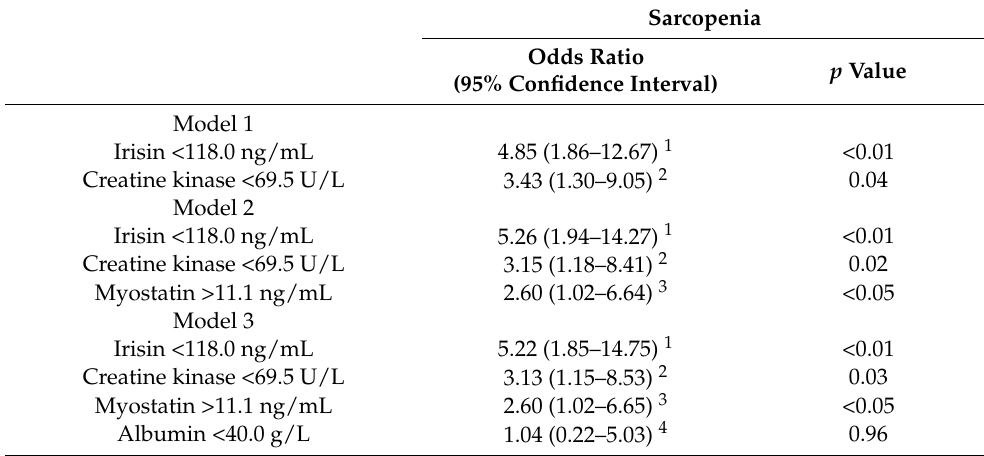
Table 3. Associations between the risk of sarcopenia and coenzyme Q10 and the skeletal muscle protein